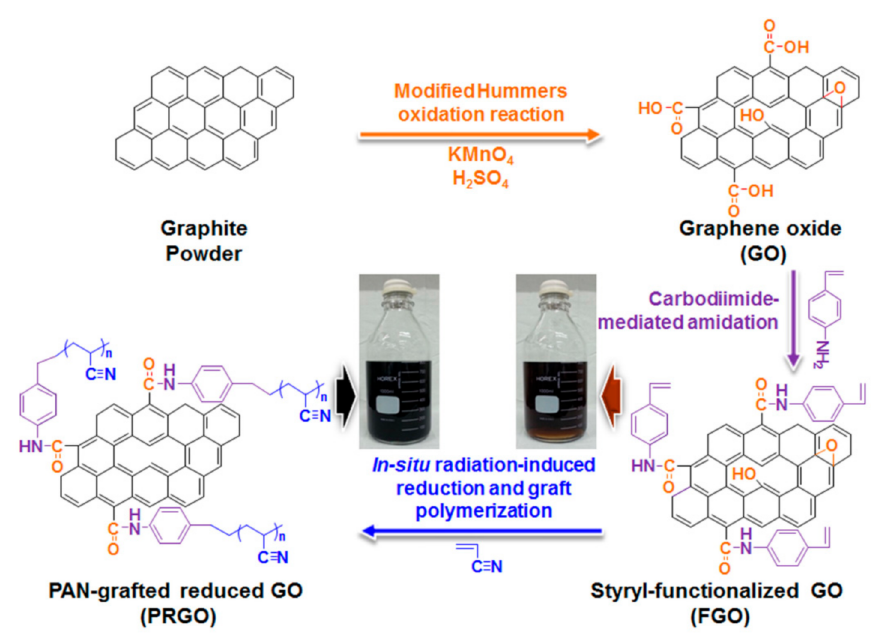
Figure 12. Schematic illustration for the synthesis of PRGO (insets represent the photograph of the respective FGO and PRGO solutions in 800 mL DMF). Reproduced from [103] with the permission of